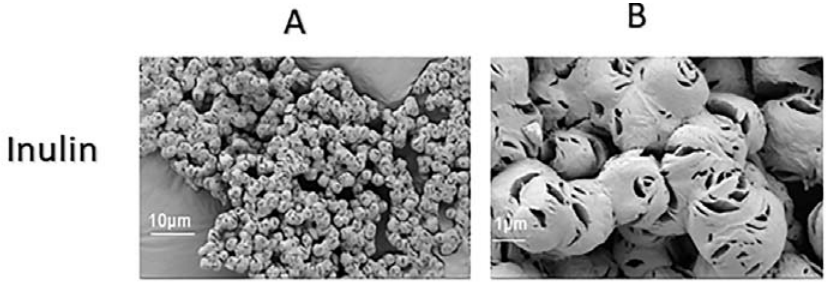
Figure 3. SEM images of raw inulin at two different magnification sizes: 10 μ m ( A ) and 1 μ m ( B ).